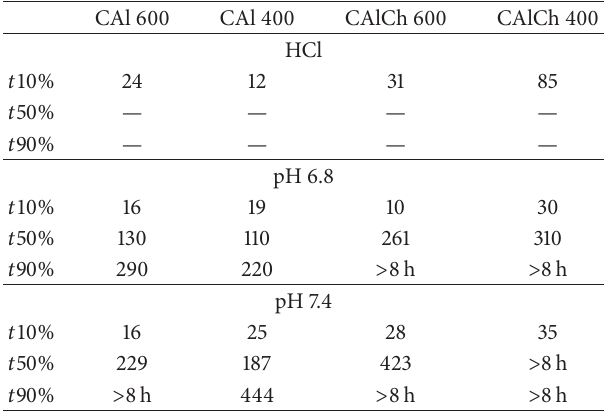
Table 3: Time (min) necessary to release 10, 50, and 90% of the loaded